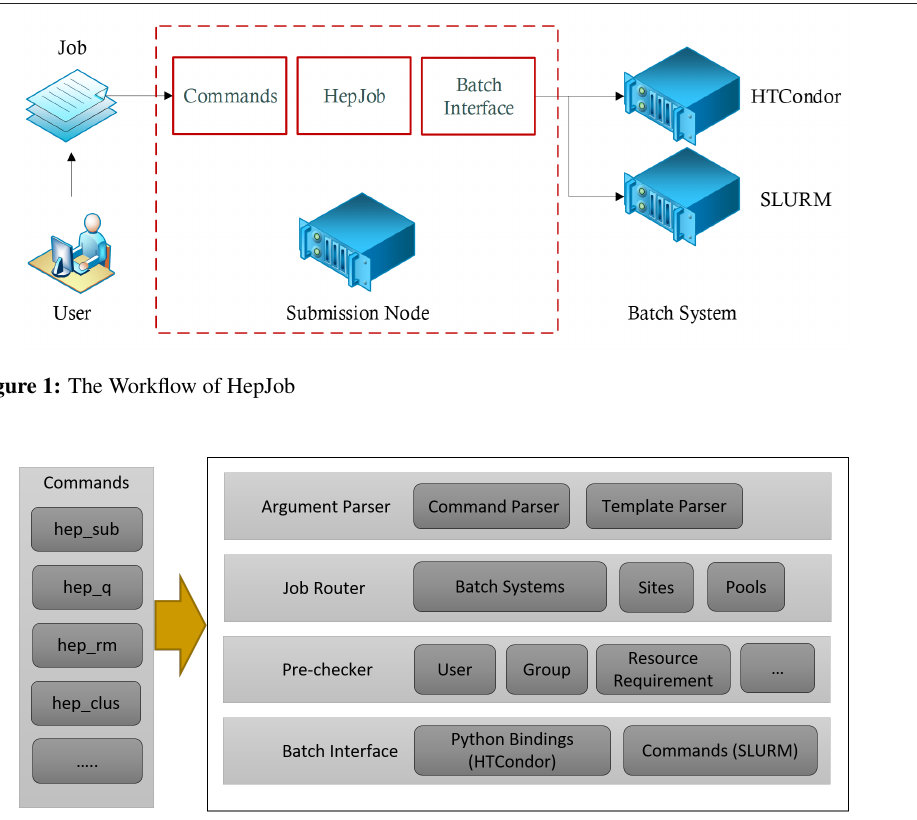
Figure 2: Structure and